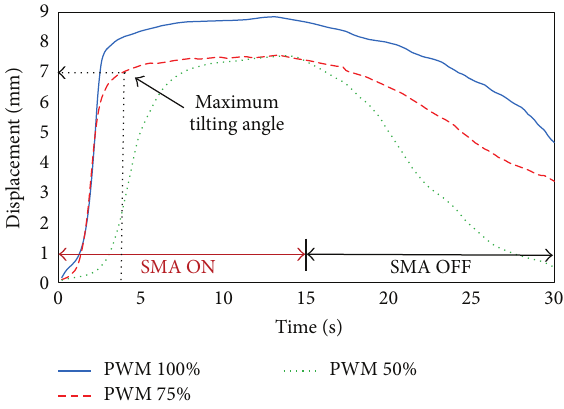
Figure 9: Temporal response of SMA actuator with different PWM duty